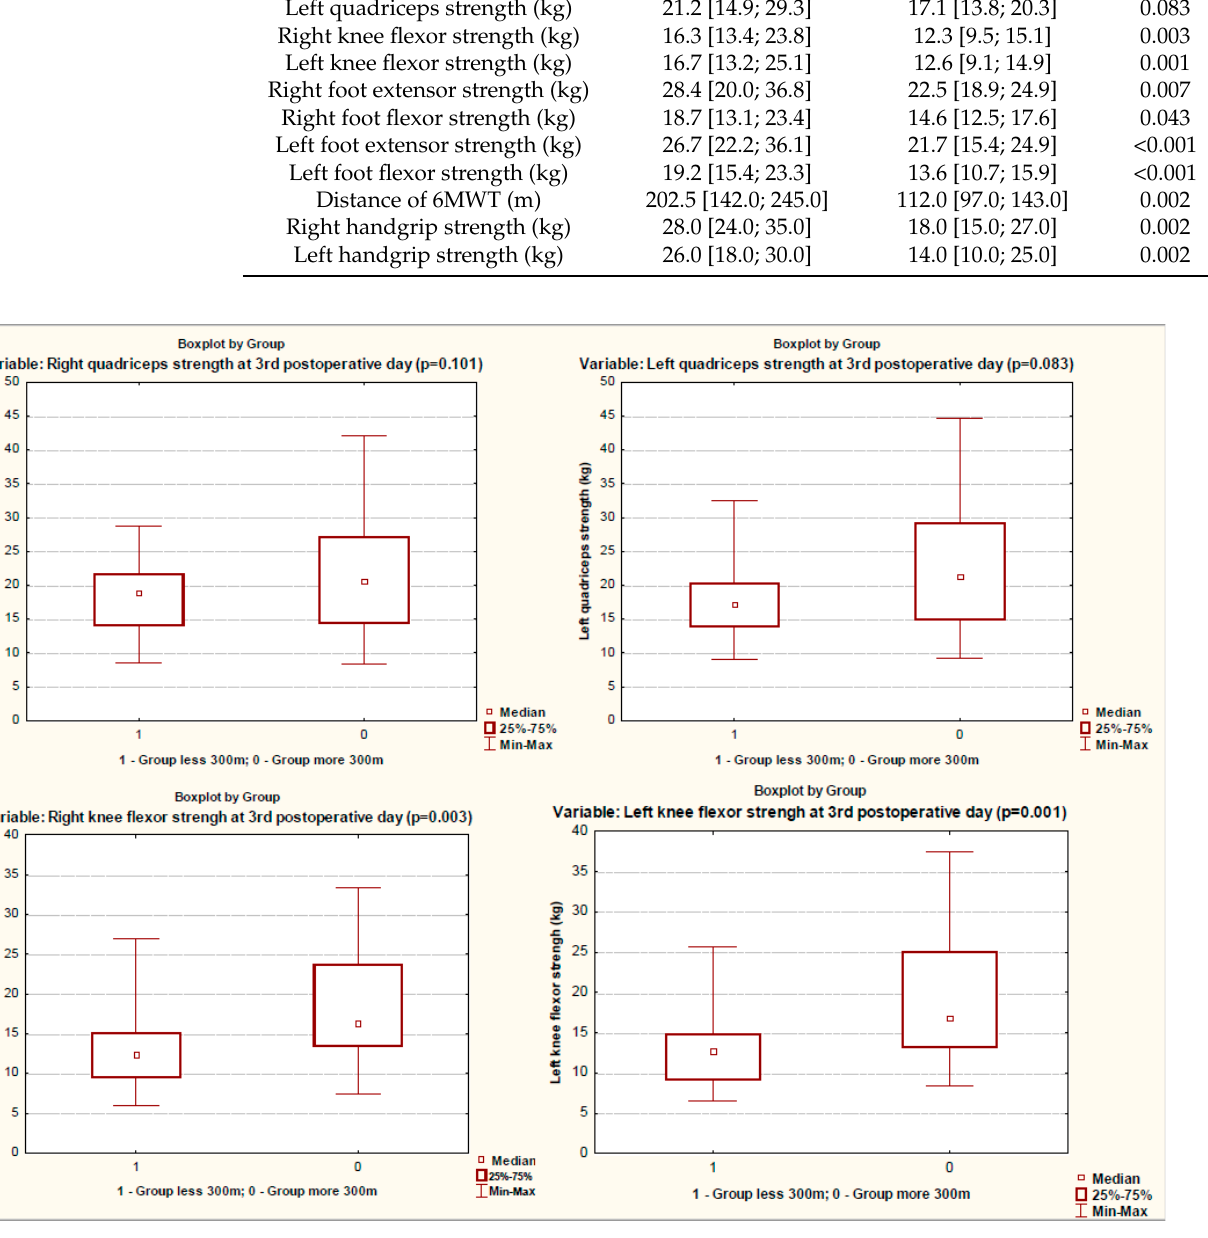
Figure 2. Quadriceps and knee flexor strength in groups on 3rd postoperative day.